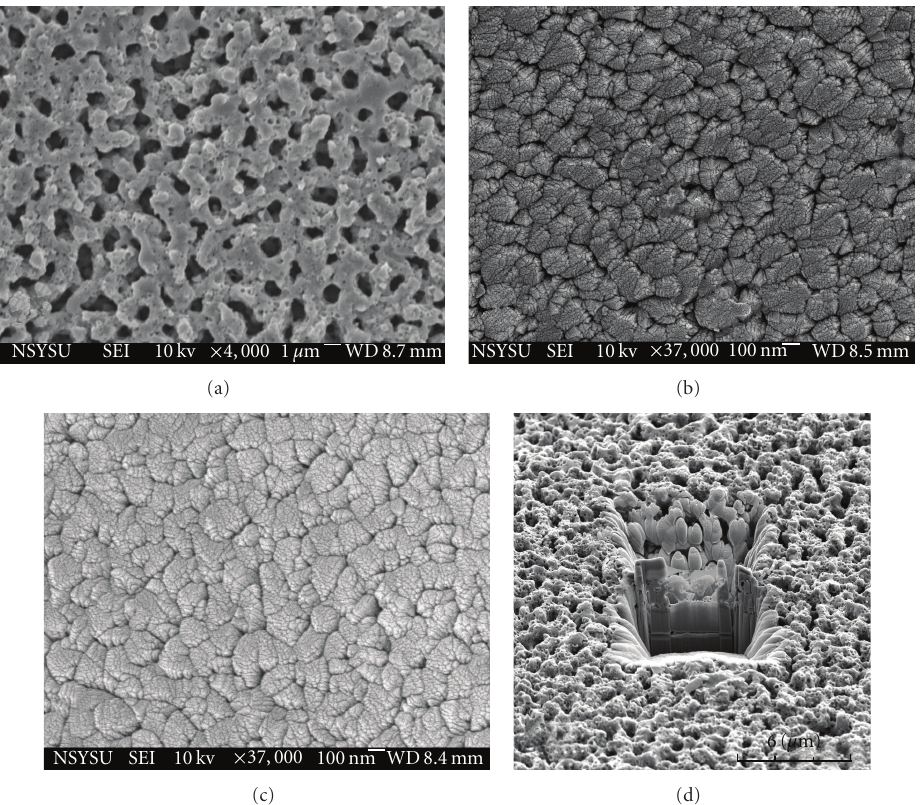
Figure 4: SEM plain images of (a) mTiO 2 , (b) nTiO 2 , and (c) uTiO 2 films and (d) FIB projected image of the mTiO 2 film, where the squared crater at the center was the TEM sample cut